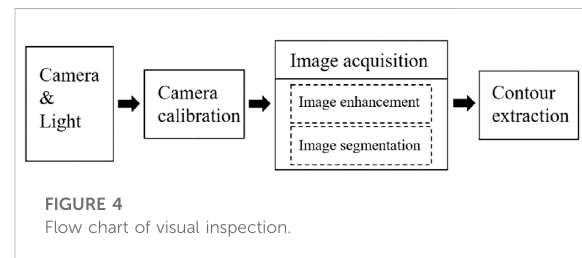
FIGURE 4 Flow chart of visual inspection.